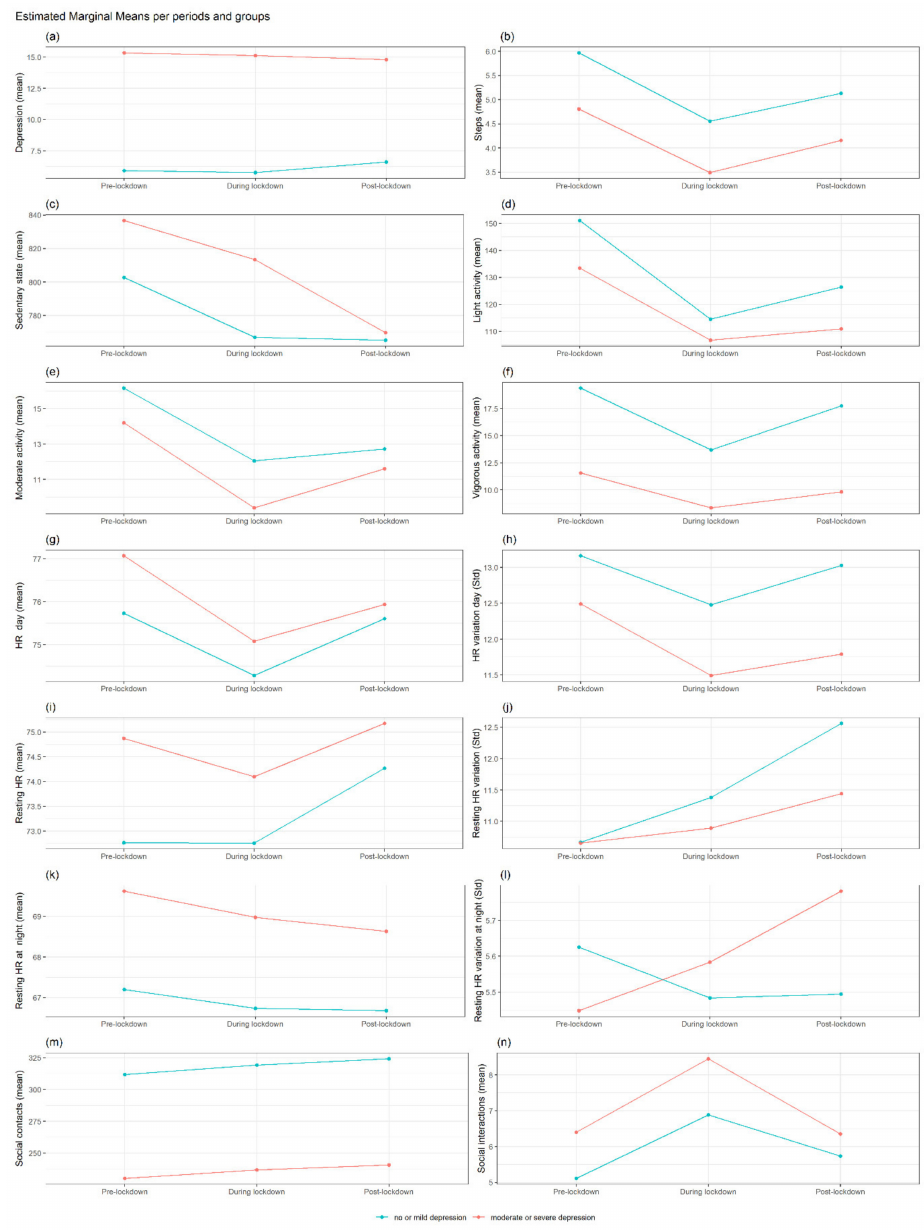
Figure 1. Interaction trajectories by depression status in MDD group. Estimated marginal means per MMD groups based on depression status (moderate or severe depression versus no or mild depression at baseline) across the three periods (pre, lockdown and post-lockdown) for depression severity ( a ), activity features ( b – f ), HR features ( g – l ), sociality ( m , n ). Note: PHQ-8 = depression severity, Steps = mean steps per day, Sedentary = Number of minutes per day classified as sedentary. Light, moderate and vigorous activity = the number of minutes per day classified as “light”, “moderate” or “vigorous activity”, mHR day = mean heart rate (HR) during 24 h, std HR = standard deviation of HR during 24 h, restingHR day = HR at rest during 24 h, Resting HR at night = HR at rest during the night (0:00–05:59), social contacts = number of contacts in the agenda, social interactions = interactions trough social